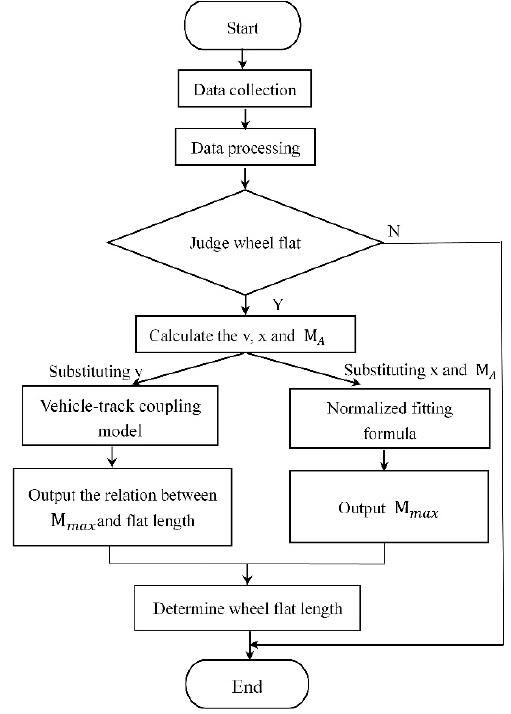
Figure 13. The flow chart of the wheel flat calculation.